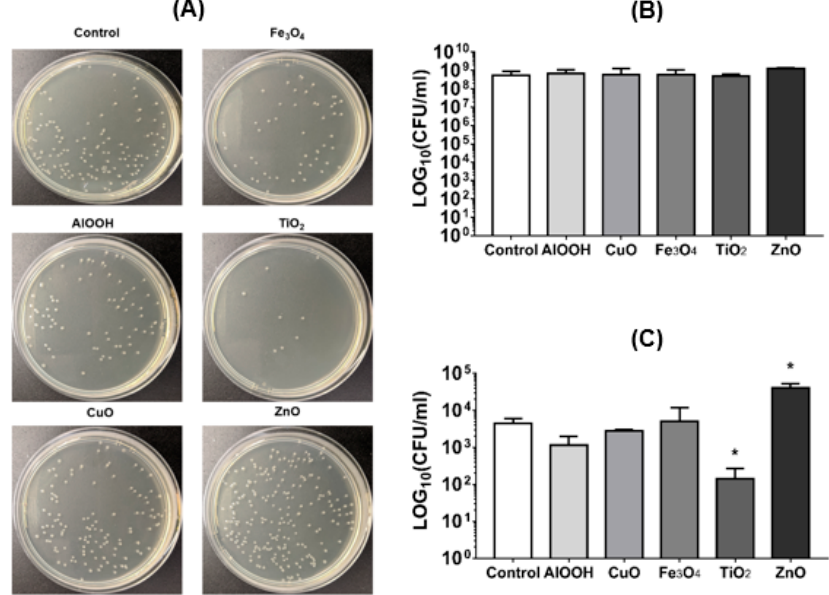
Figure 2. Effect of MONPs on transformation. ( A ) Images of bacteria colony-forming units (CFU) of transformants on lysogeny broth (LB)-agar plates with ampicillin (100 µg/mL) after transformation by pGEM-T plasmid in MONPs presence (50 µg/mL). ( B , C ) Statistical analysis of the CFU number in the presence of MONPs (50 µg/mL) before transformation ( B ) and after transformation ( C ). The presented results are the mean of three independent experiments (three replicates in each) ± standard deviation. * p < 0.05.